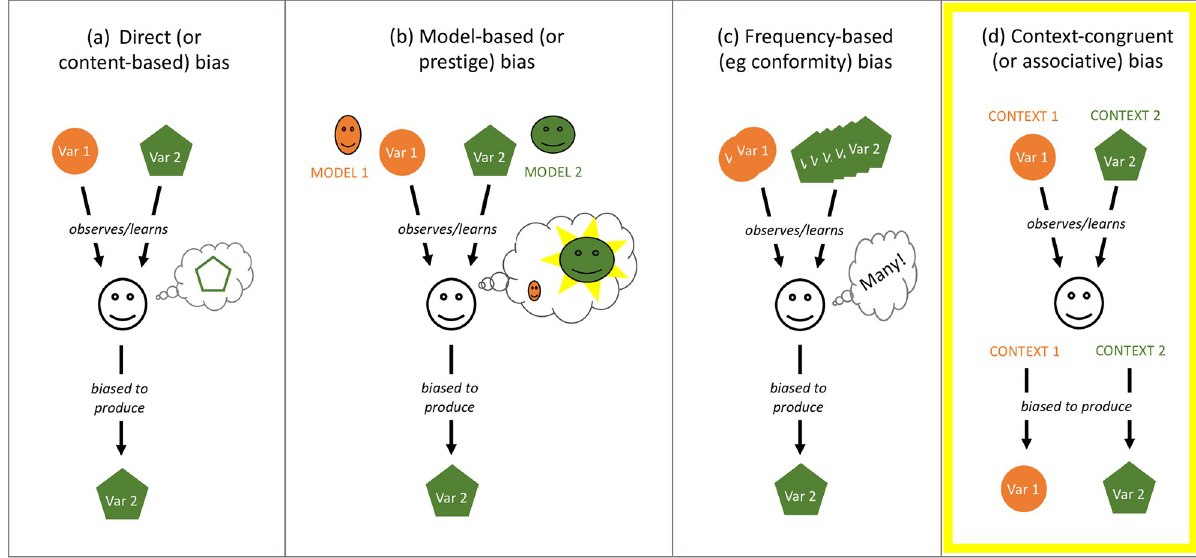
Fig 1. Three classic transmission biases and a new one. (a) Direct or content-based bias favours the adoption of variants depending on their perceived attractiveness, utility, ease etc. (b) Model-based bias favours variants depending on who produced (or modeled) those variants. (c) Frequency-based bias disproportionately favours variants that have high (or low) frequency. (d) Context-congruence or associative bias favours variants that are associated with the current context, i.e. that were learned, observed or produced in the same